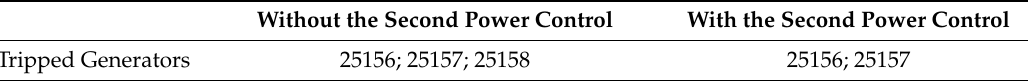
Table 4. Reduced tripped generator with the second power control scheme in N-2